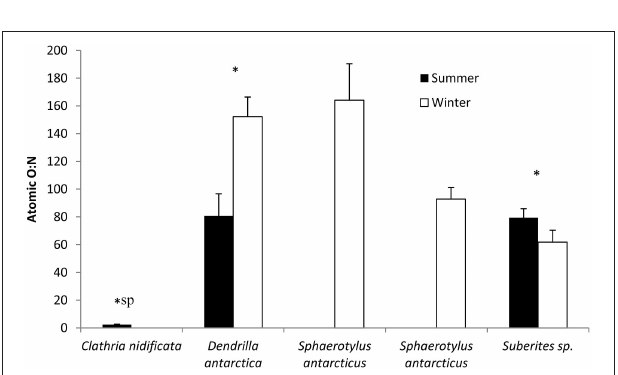
FIGURE 5 | O:N ratio of sponges in summer and winter. * sp indicates a significant difference between species (ANOVA, P < 0.05 ). * Indicates a signficant within species difference between seasons (ANOVA, p < 0.05